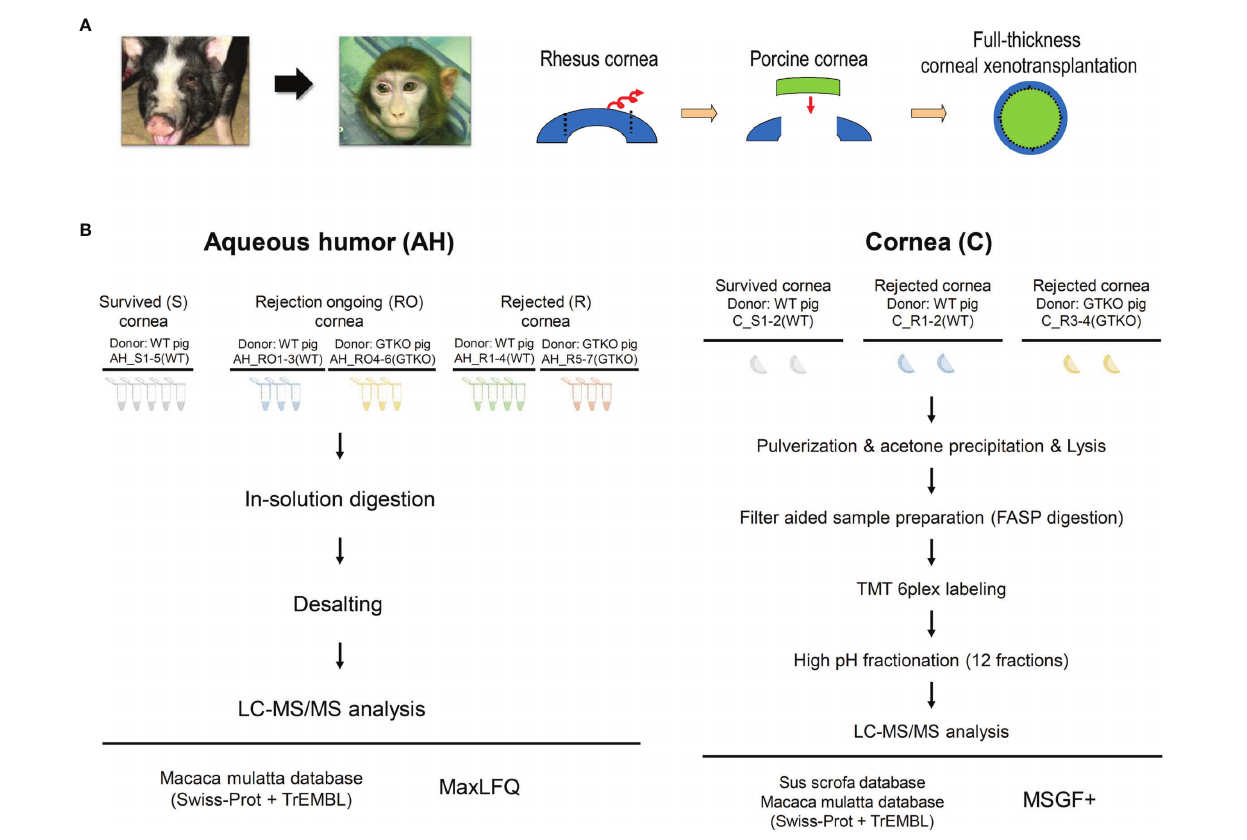
FIGURE 1 | (A) Schematic diagram depicting the procedure used for full-thickness corneal xenotransplantation. A clinically applicable porcine corneal donor button of 7.5 mm was used on the 7.0-mm non-human primate recipient bed in all cases. (B) Overall experimental work fl ow of the proteomics experiments. Aqueous humor (AH) and cornea were lysed and digested into peptides. Digested peptides were analyzed using LC-MS/MS. AH samples were subjected to LFQ analysis and cornea samples were subjected to TMT quantitative analysis. WT, wild type; GTKO, a -1,3-galactosyltransferase gene-knockout; LC, liquid chromatography; LFQ, label-free quanti fi cation; TMT, tandem mass